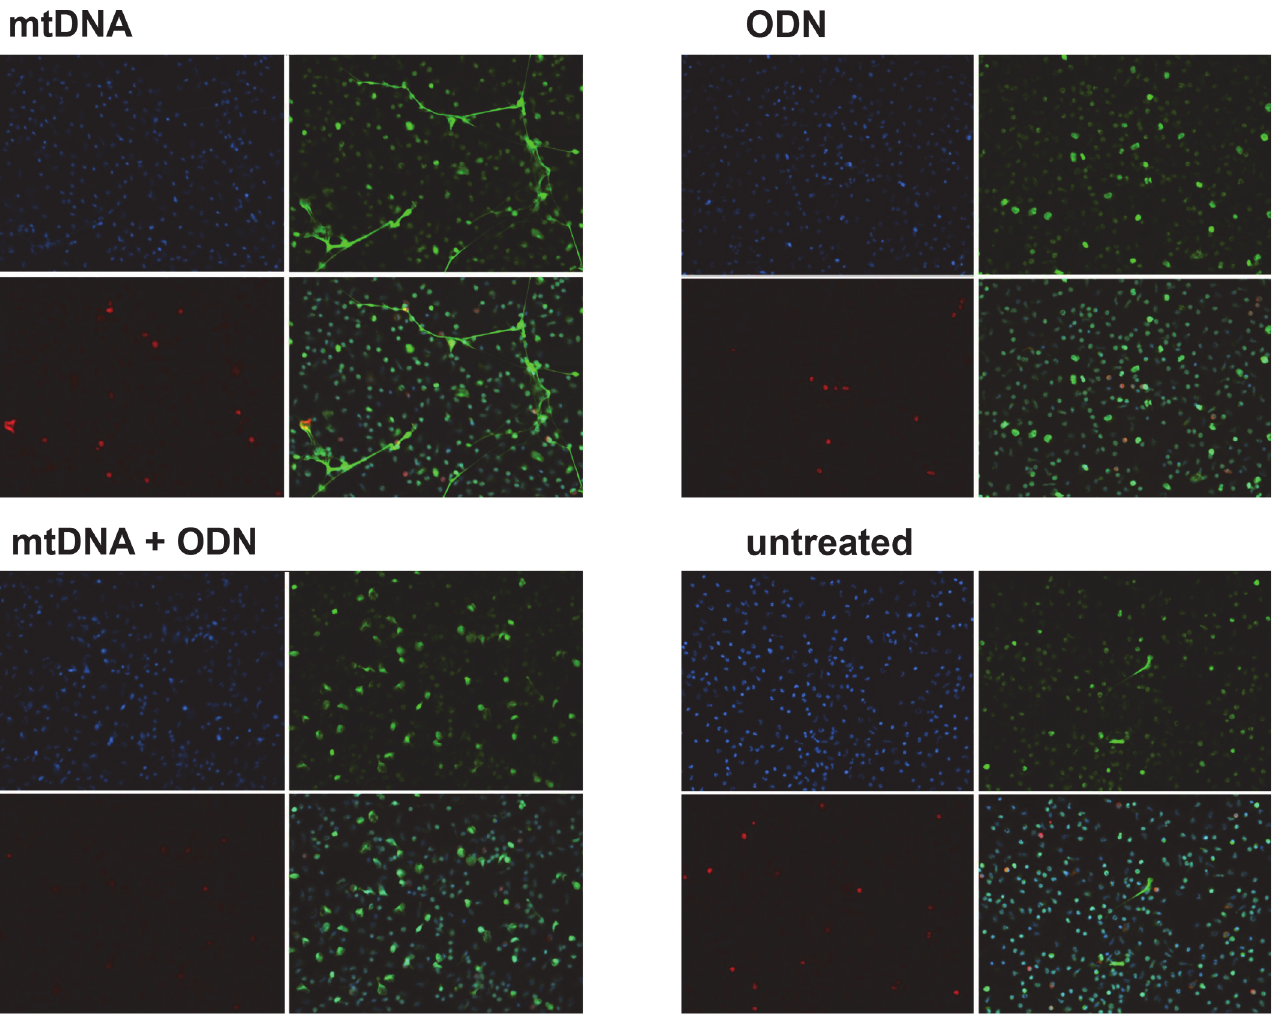
Fig 3. MtDNA induces NET formation via TLR9. PMN were attached to coverslips and treated with mtDNA (50 μ g/mL, A ), ODN (5 μ M, B ), mtDNA and ODN ( C ) or medium ( D ) for 3 – 4 h. NETs were detected as described in Materials and Methods. Experiments were repeated at least three times. Magnification